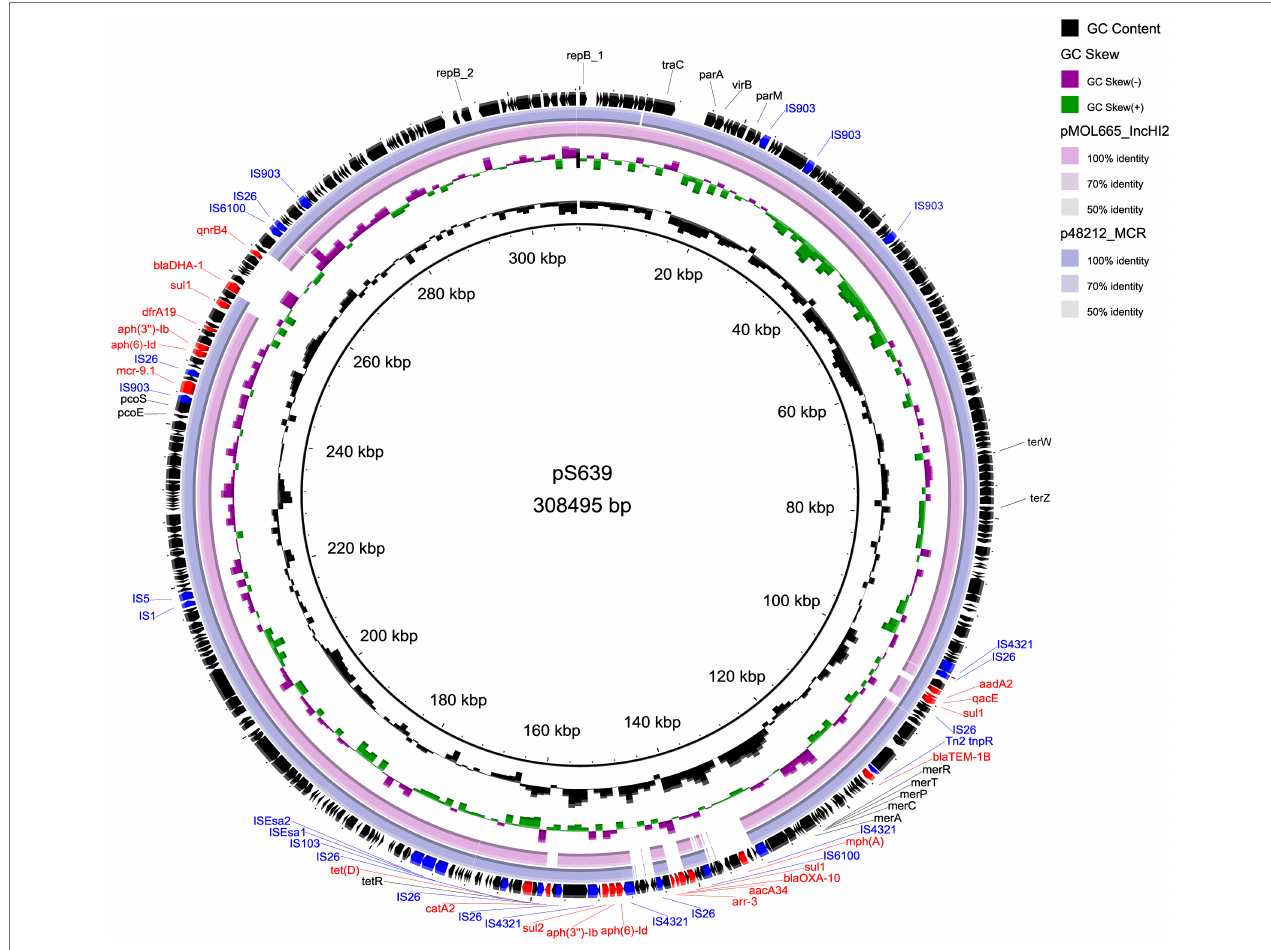
FIGURE 2 | Comparison of circular structures of pS639 and its similar plasmids. Arrows indicate the direction of predicted transcription of each gene. Red arrows indicate antibiotic resistance genes. Blue arrows indicate insertion